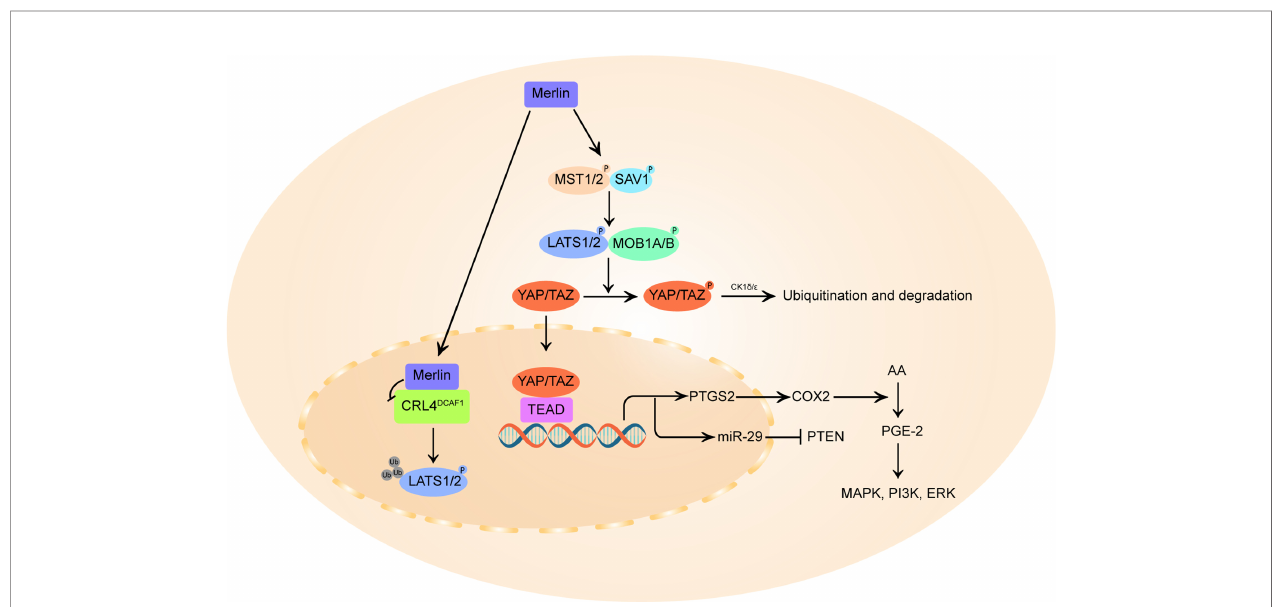
FIGURE 2 | Schematic diagram of merlin and Hippo pathway signaling. On the one hand, merlin initiates the Hippo pathway by directly activating mammalian STE20-like protein (MST1/2), which in turn phosphorylates large tumor suppressor homolog 1/2 (LATS1/2), or by recruiting LATS 1/2 to the plasma membrane for phosphorylation by MST1/2 kinases. The activated LATS1/2 directly phosphorylates Yes-associated protein (YAP) at Ser 397 and transcriptional coactivator with PDZ- binding motif (TAZ) at Ser 311 , priming the neighboring phosphodegron motif for phosphorylation by CK1 d / ϵ kinases and multi-level control of YAP/TAZ levels. In parallel, merlin also translocates to the nucleus and blocks the activity of the nuclear E3 ubiquitin ligase CRL4 DCAF1 , which promotes the ubiquitylation of LATS1/2 to activate YAP. In merlin-de fi cient cells, YAP/TAZ accumulates in the nucleus and forms hybrid transcription factors with TEA domain (TEAD) family proteins to promote the transcription of pro-proliferative genes, including PTGS2 and miR-29. PTGS2 encodes cyclooxygenase-2 (COX-2) that catalyzes the conversion of arachidonic acid (AA) to prostaglandin E-2 (PGE-2), thus promoting PGE-2 mediated MAPK, ERK, PI3K pathway. By inducing miR-29, YAP can also inhibit the translation of phosphatase and tensin homolog (PTEN), a broadly downregulated tumor suppressor in vestibular